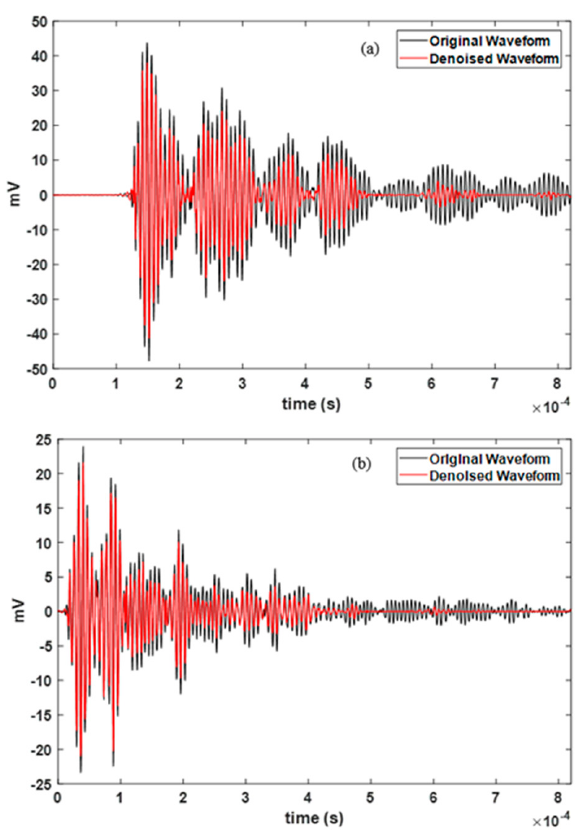
Figure 21. Original and de-noised waveforms.